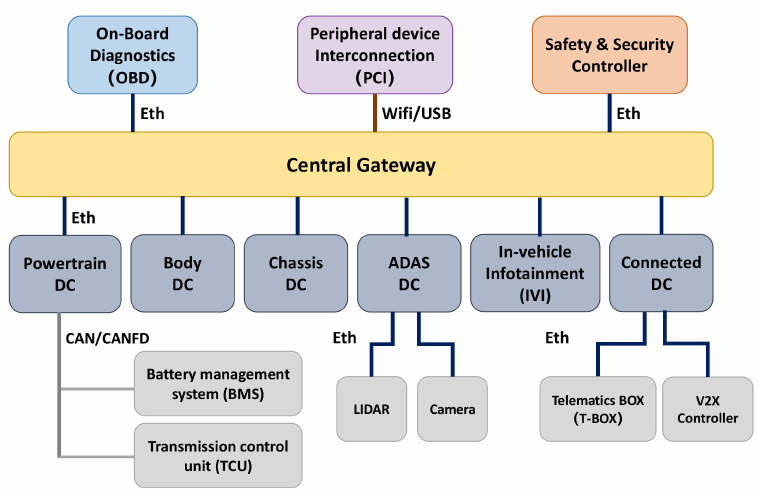
Figure 3. General domain-centralized electrical/electronic